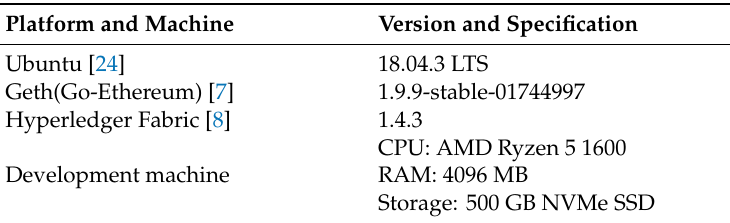
Table 1. Development